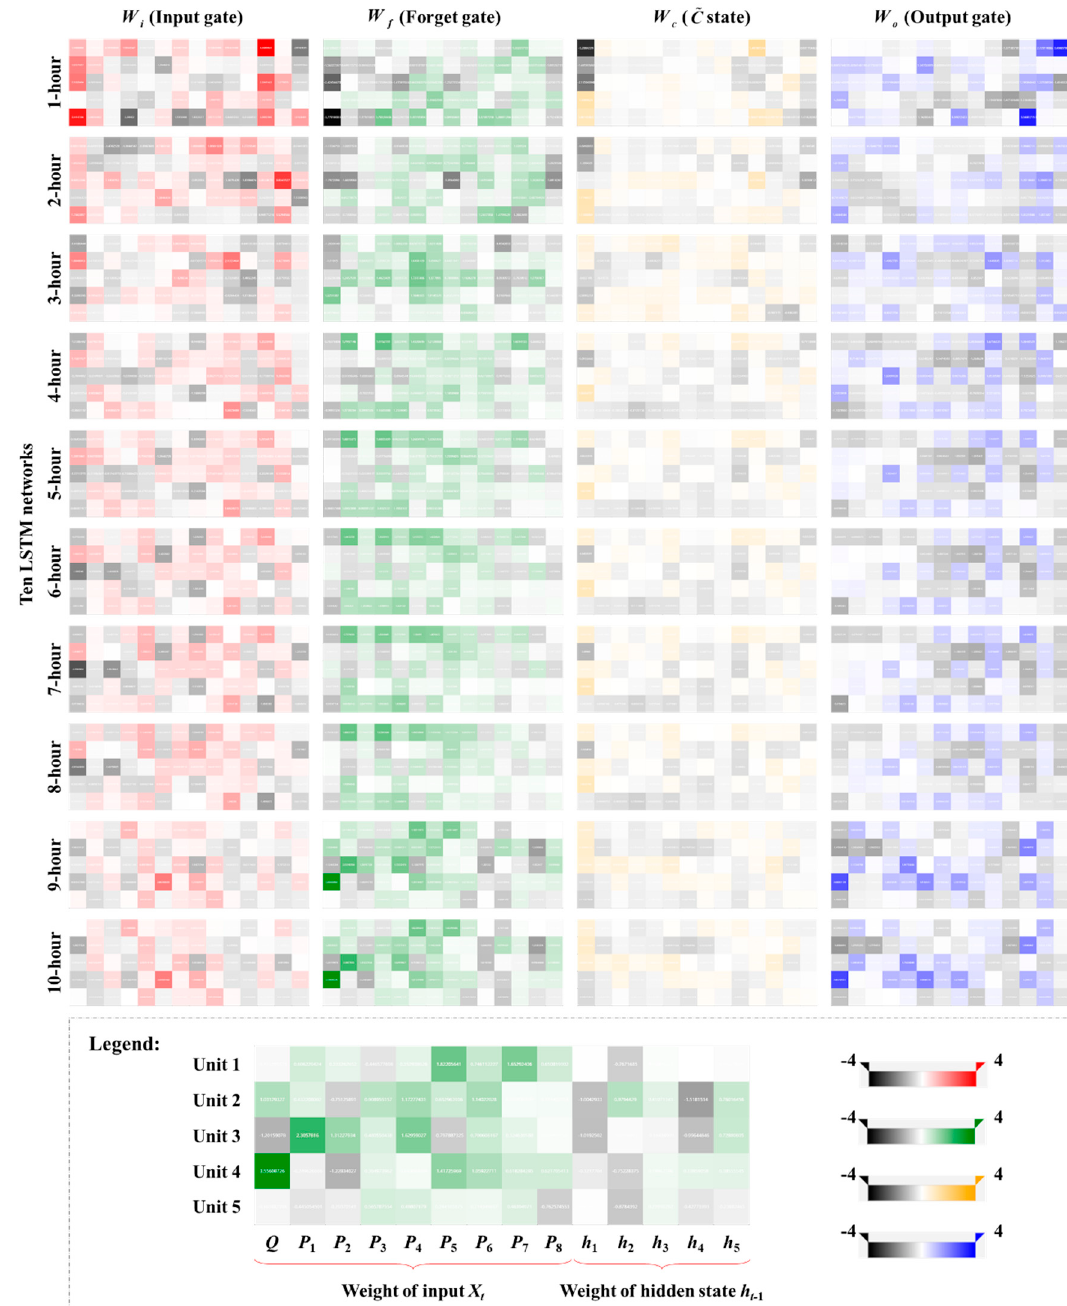
Figure 11. Visualization of weight matrices in LSTM networks.